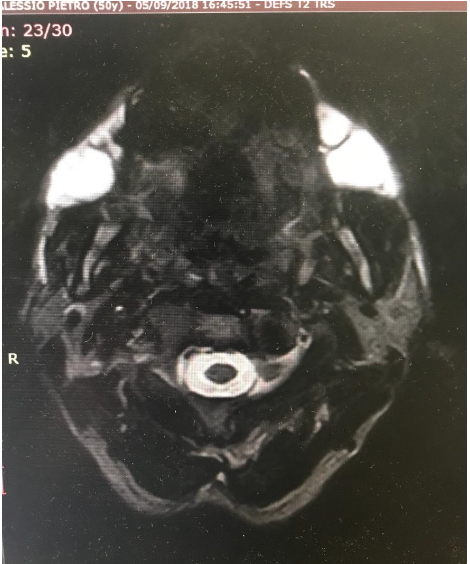
Figure 9. Magnetic Resonance Imaging (MRI) of bilateral huge abscess in a patient (the same patient shown in Figure 8) receiving polyacrylamide hydrogel injections 10 years after the treatment.